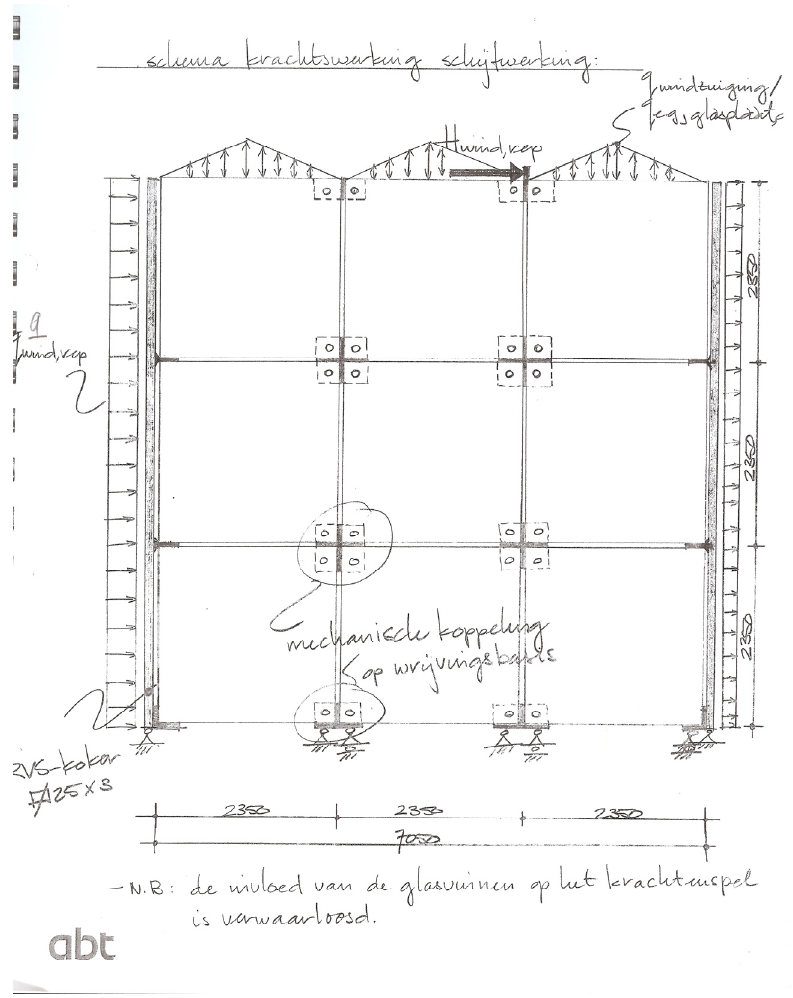
Figure 5: The built of a glass wall prepared for acting as a stability